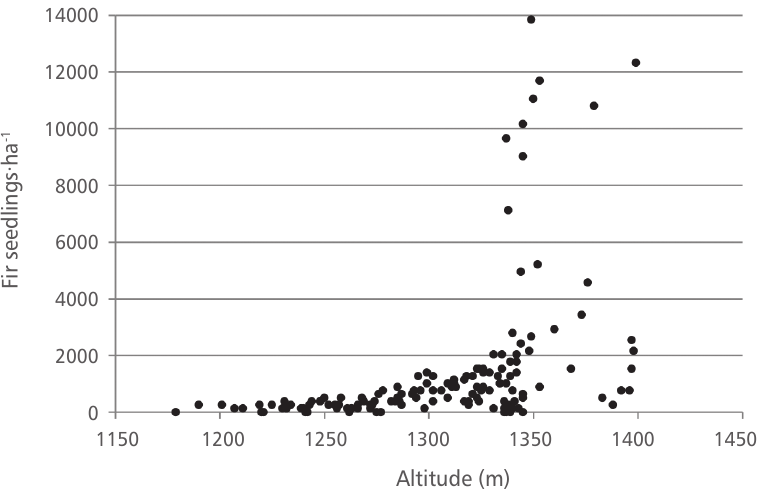
FIGURE 2. Scatterplot of fir seedling densities against altitude above sea